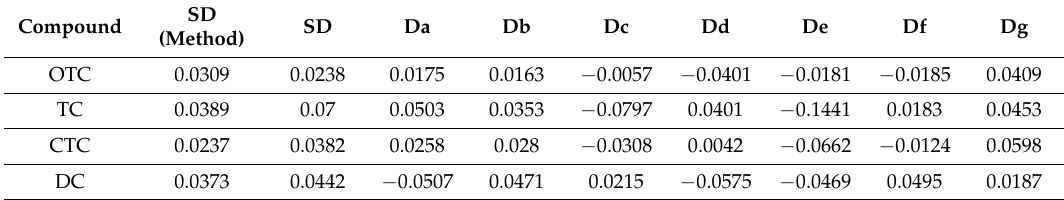
Table 3. Ruggedness